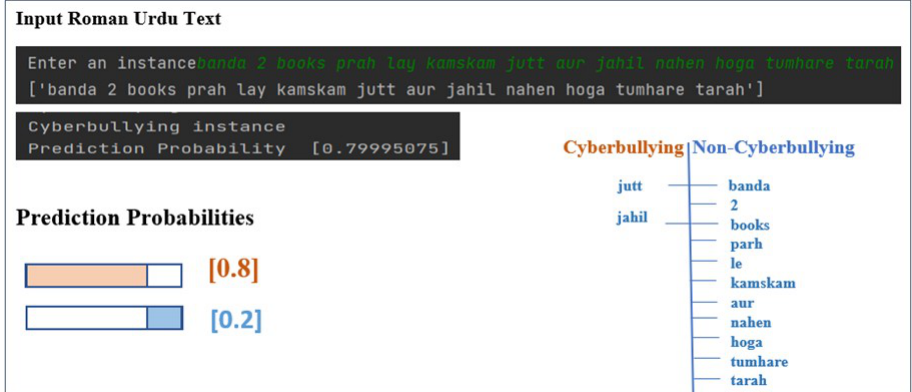
Figure 16. Prediction probability score for explicit Roman Urdu